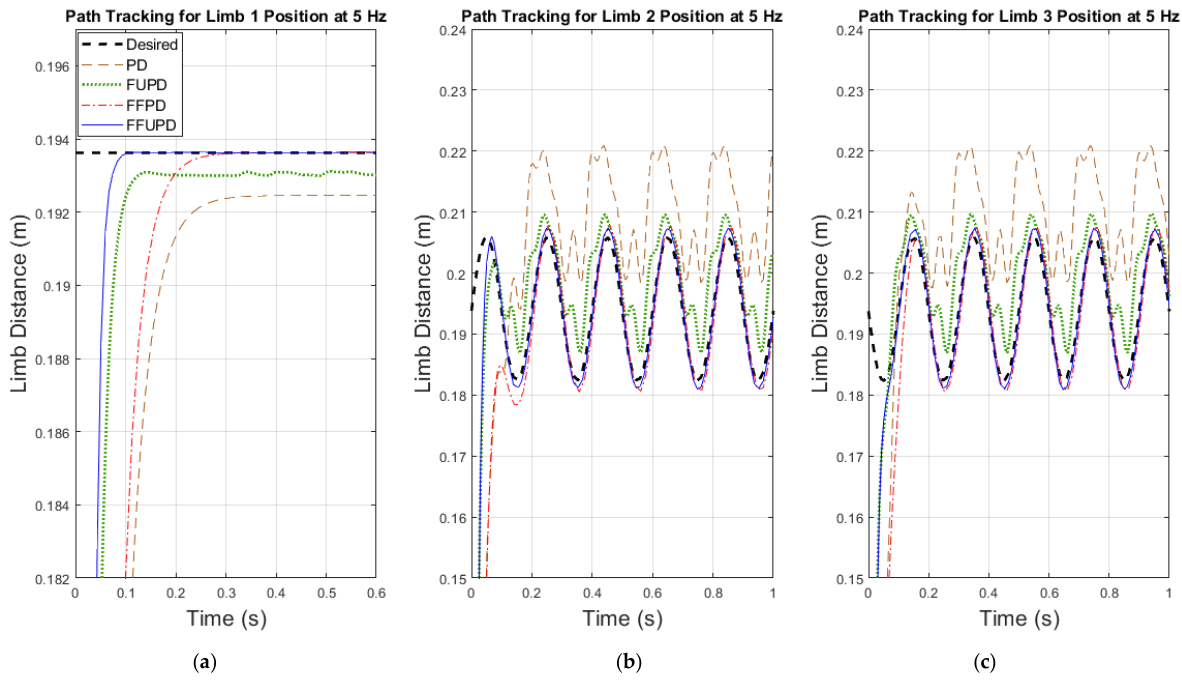
Figure 11. Results for set 1 of simulations at 5 Hz: ( a ) shows how four controllers do great performance at reaching static positions, however, PD and FUPD never reach desired setpoint; ( b , c ) show how error increases at high frequencies with PD and FUPD controllers, making limbs 2 and 3 unable to follow desired trajectories.